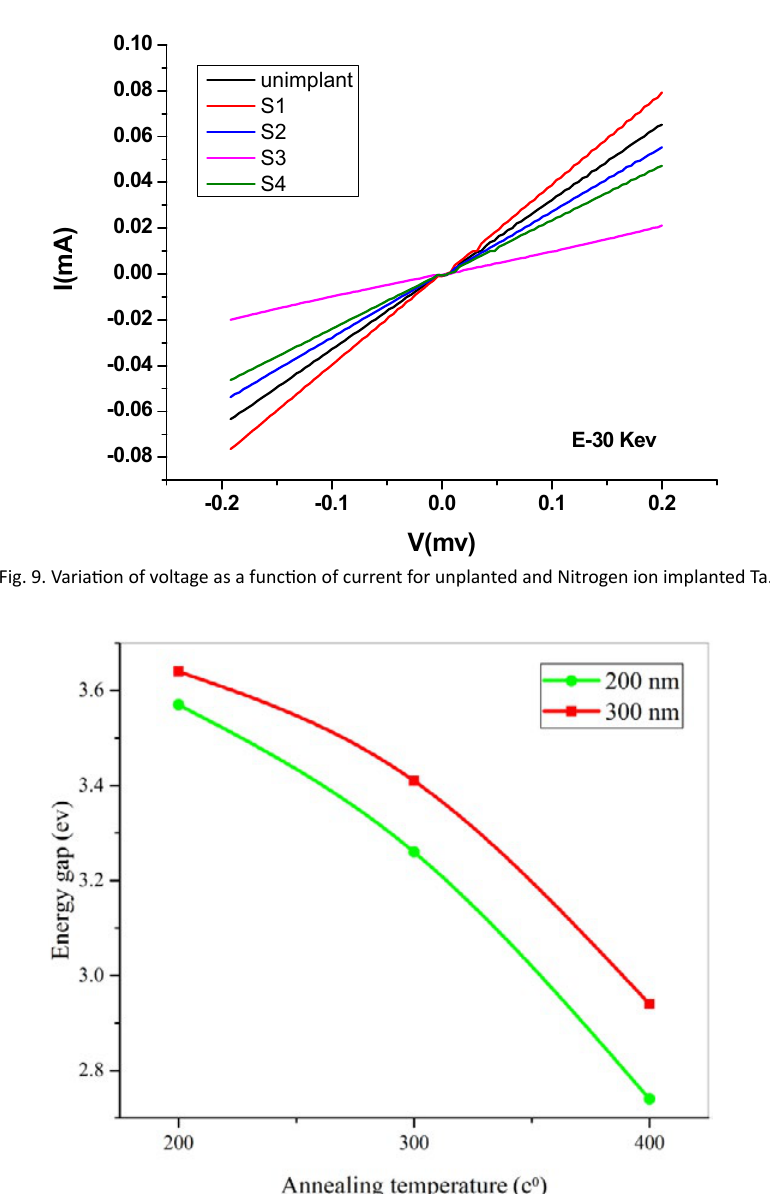
depends on annealing 3